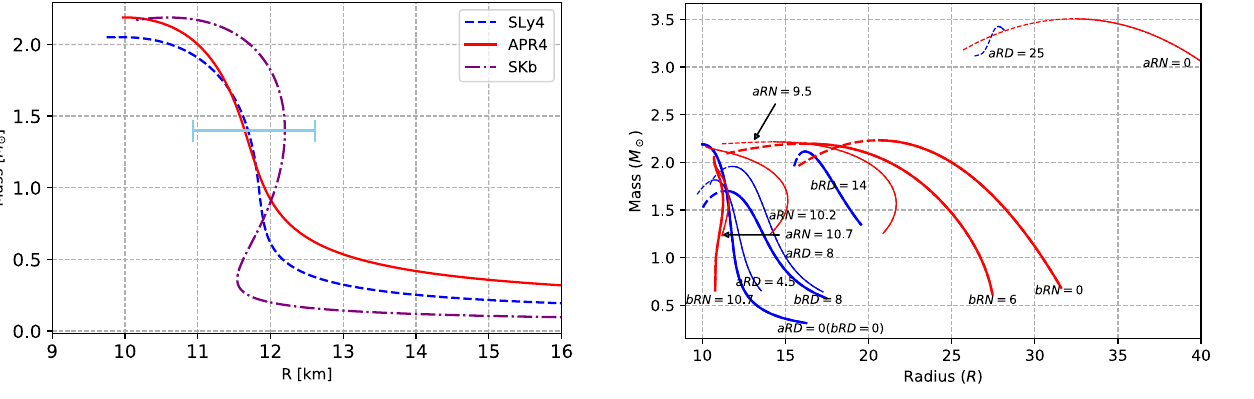
Fig. 4 Mass–radius relations of the hybrid stars of type (I) and (II) in Fig. 1, which are made of nuclear matter of APR4 EoS and dark matter of EoS (1) with B = 0 . 035 or 0 . 055. The notations are the same with that in Fig. 3